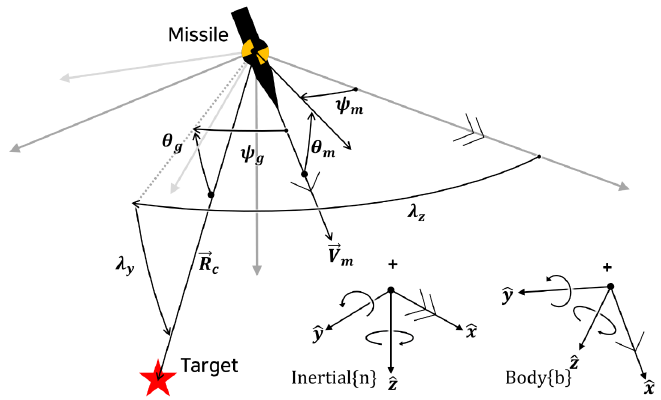
Figure 1. Geometry of the pseudo-5DOF missile